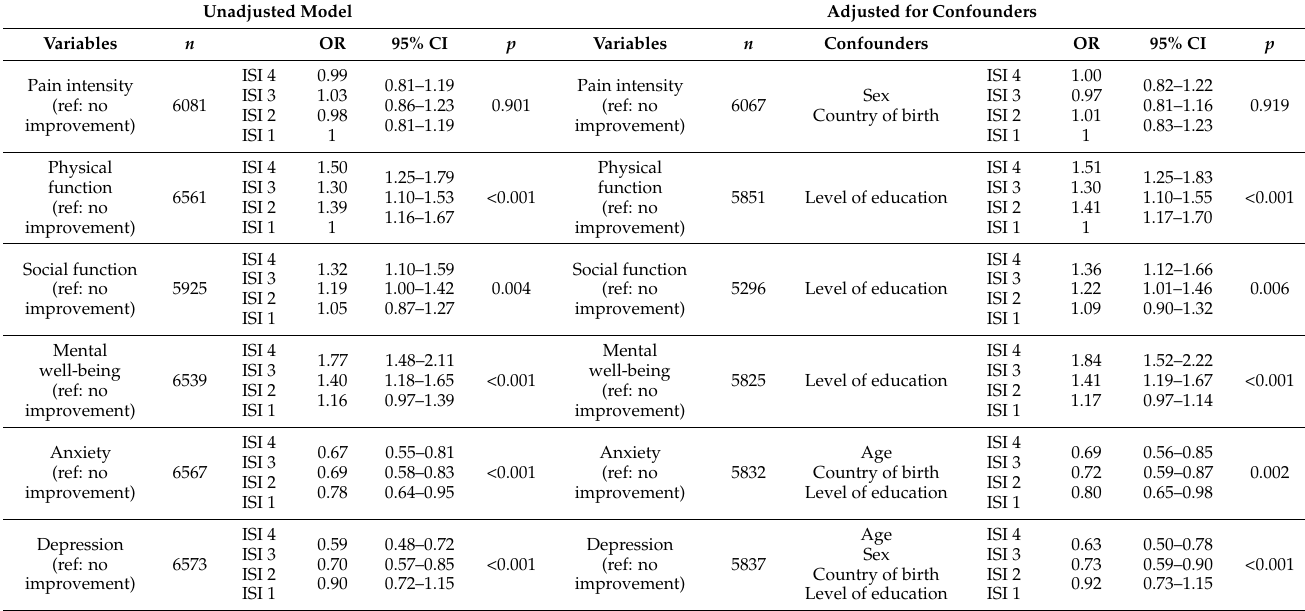
Table 6. Logistic regression analysis of the study group completed IPRP with treatment outcome as binary dependent variable (improvement/no improvement). Degree of insomnia at baseline was the independent variable, with different degrees of insomnia set in relation to the chance of improving the various treatment outcomes (pain intensity, physical function, etc.) after the IPRP. Odds ratios (ORs) are presented both raw and adjusted for confounders. 95% CI = 95% confidence interval. ISI = Insomnia Severity Index, with four categories: ISI 1 = no insomnia (0–7), ISI 2 = sub-threshold insomnia (8–14), ISI 3 = moderate insomnia (15–21) and ISI 4 = severe insomnia